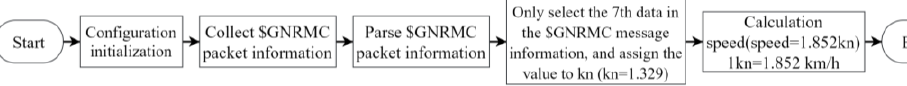
Figure 2. GNSS NMEA protocol analysis process.